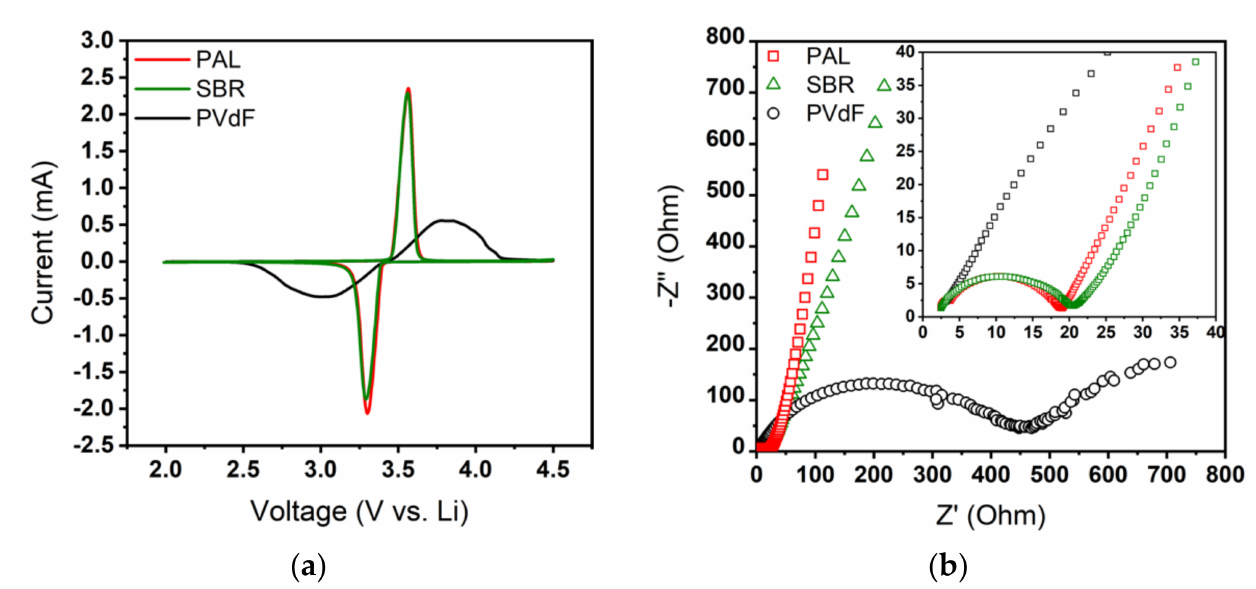
Figure 4. ( a ) CV and ( b ) impedance spectroscopy (EIS) of the LFP electrodes containing different